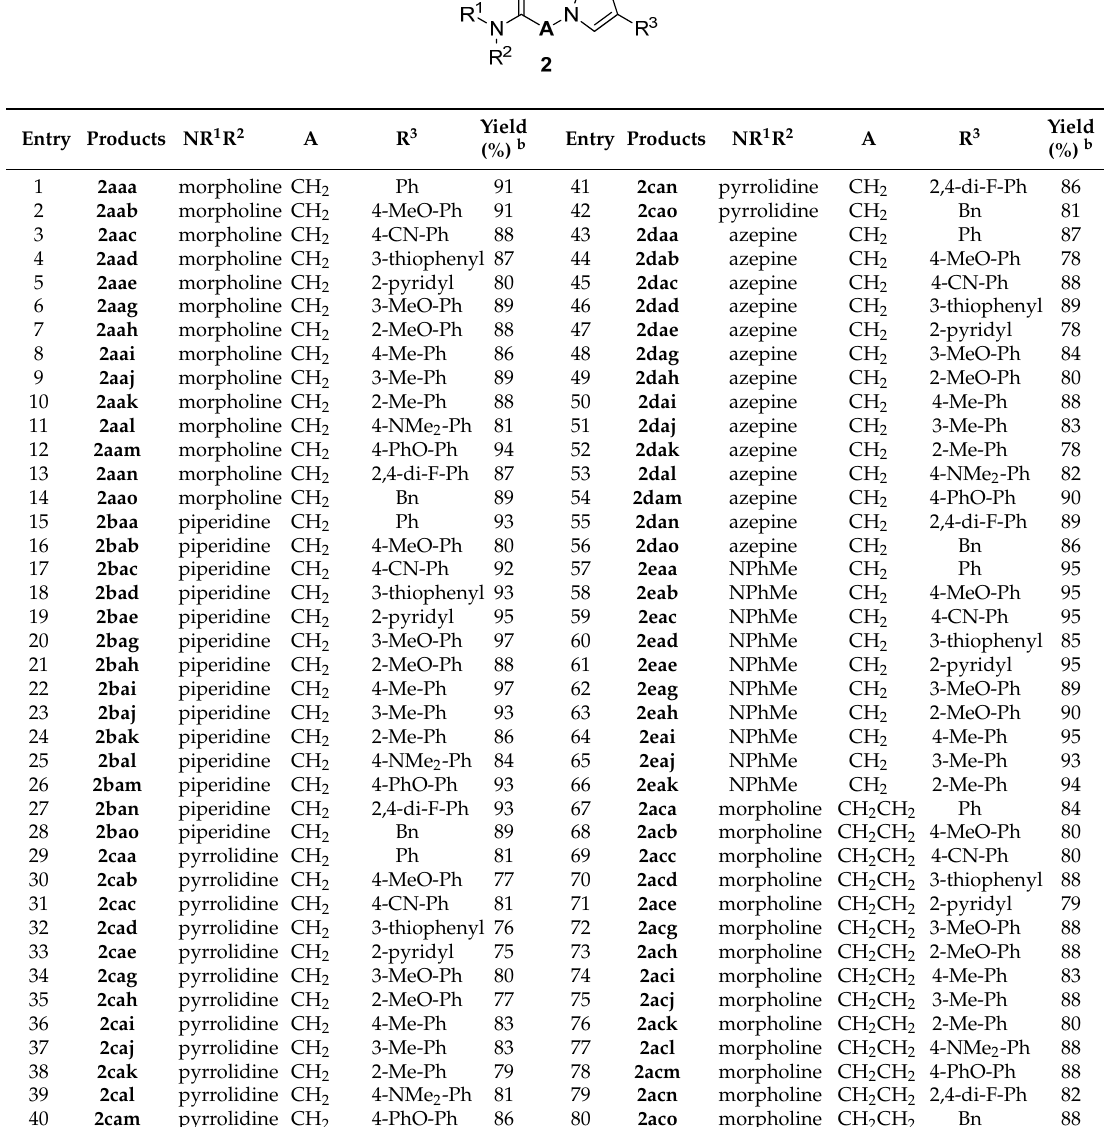
Table 2. Prepared tertiary 1,2,3-triazoloamide derivatives 2 . a